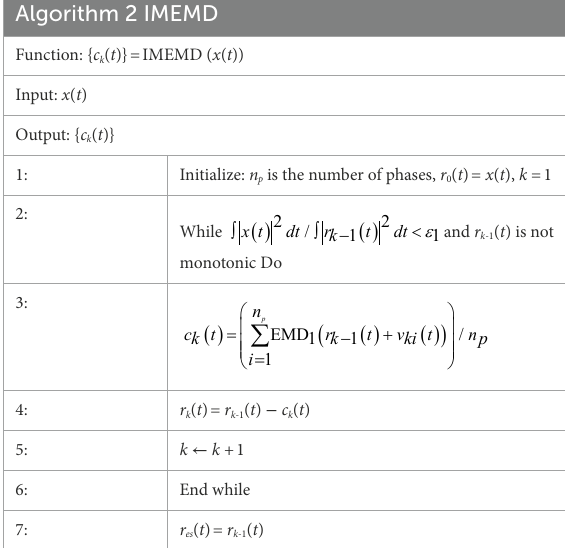
TABLE 2 The algorithm of IMEMD. Algorithm 2